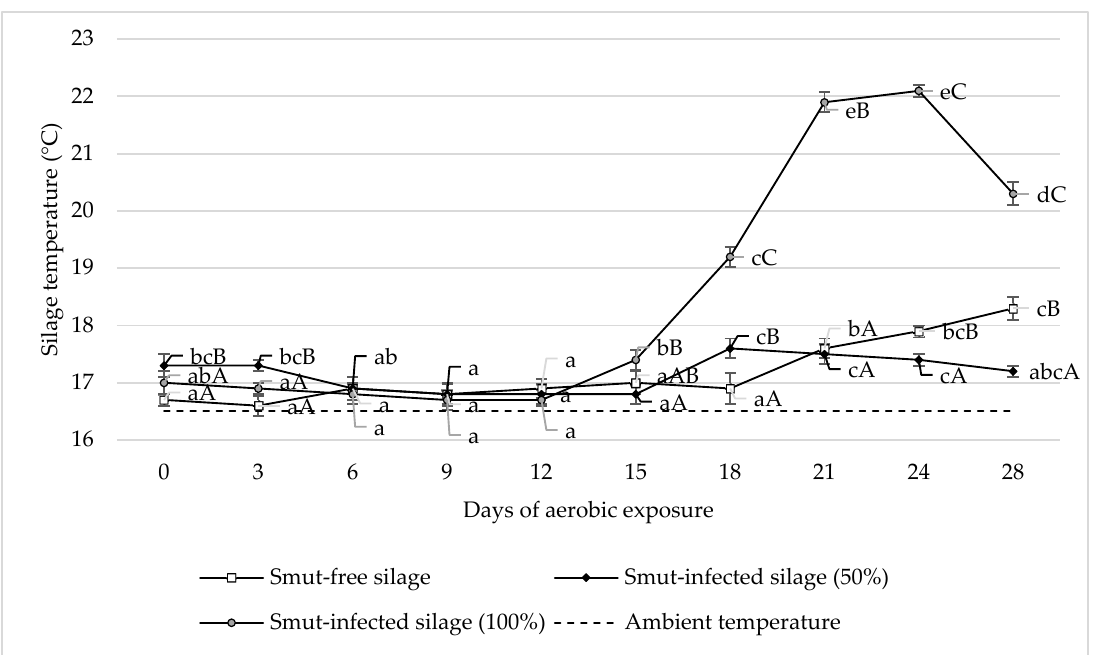
Figure 2. Change in temperatures measured in silage during aerobic exposure while silage was affected with different Ustilago maydis infection rates. Error bars represent SD. Note. Values with different uppercase letters indicate significant differences among treatments on the same day during aerobic exposure. Values with different lowercase letters indicate significant differences among days after opening for the same treatments. Values with no letters did not show significant differences among treatments or days ( p <